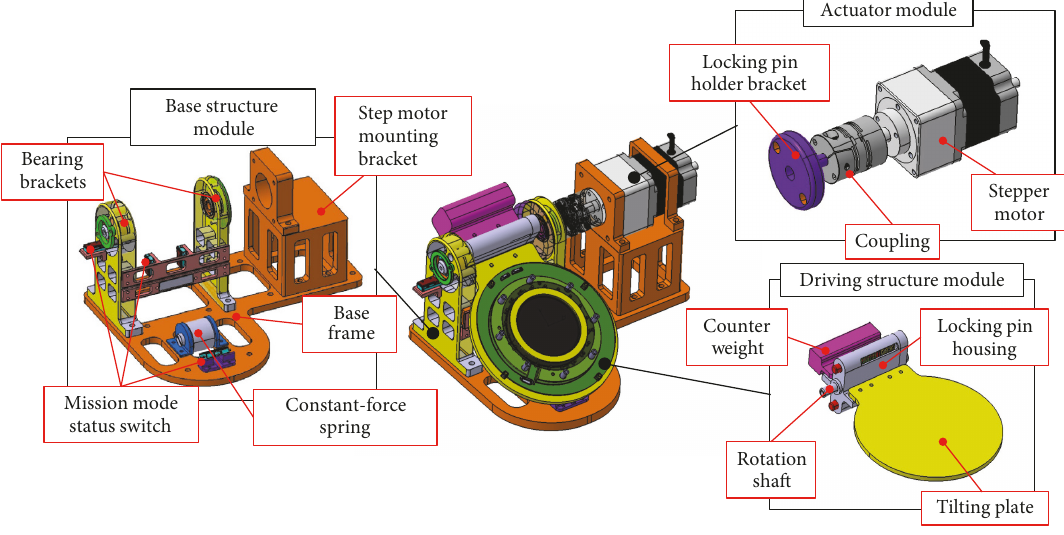
Figure 3: Composition of the tilting calibration